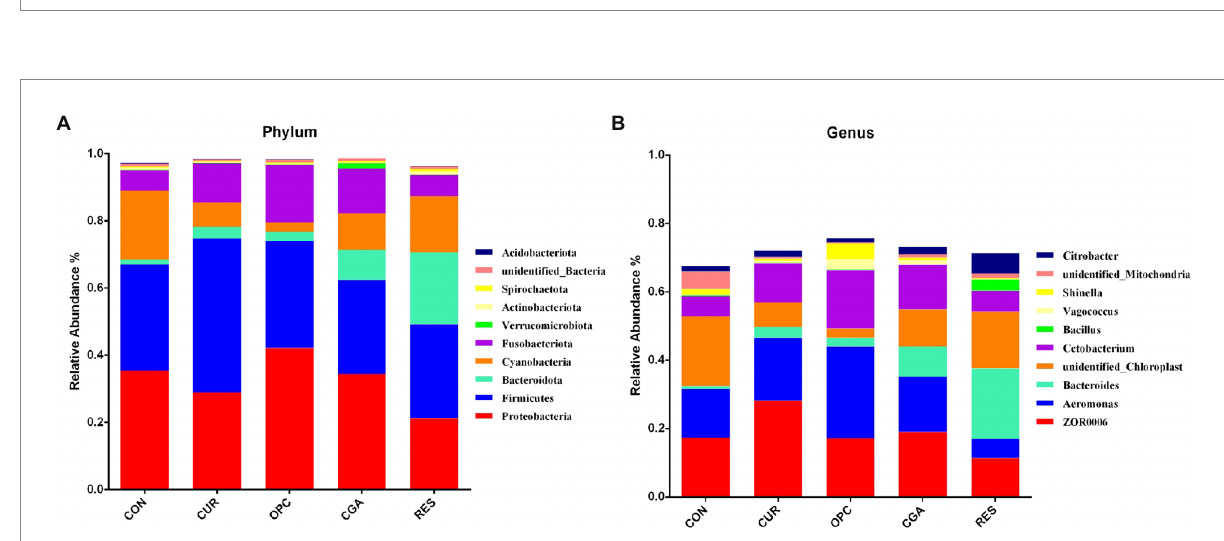
FIGURE 4 The rarefaction curves.